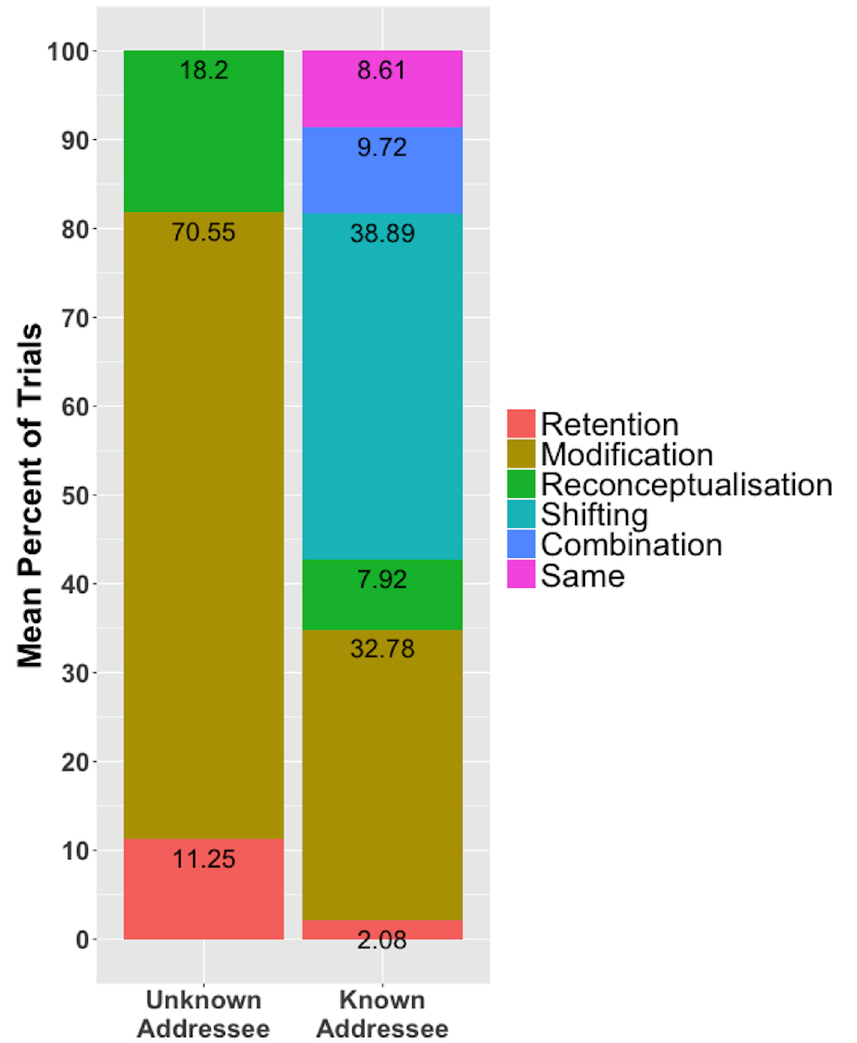
Fig 2. Mean percent of trials participants in the Unknown- and Known-Addressee conditions employed the different communication strategies.